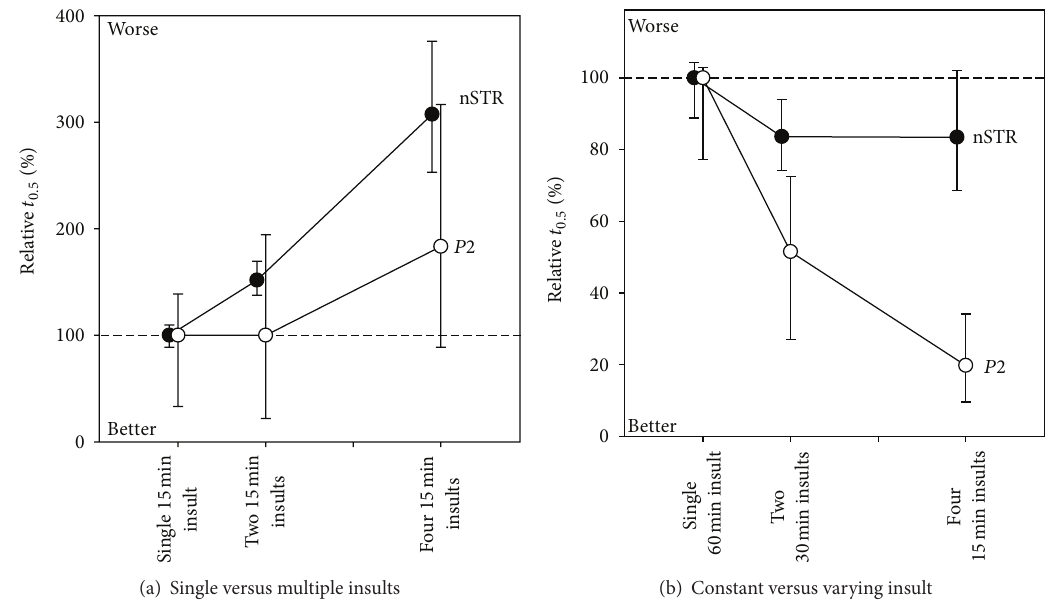
F 8: Effect of repeated IOP elevation on ERG recovery. e time taken for 50 ) recovery following repeated IOP insults is expressed , un�lled symbols) and inner retinal responses (nS�R, �lled symbols). (a) Comparison of single and multiple insults at the same IOP. (b) Comparison of single and multiple insults of equal integral. Reprinted from [78] with permission. e Association for Research in Vision and Ophthalmology remains the copyright holder. 𝑃𝑃𝑃